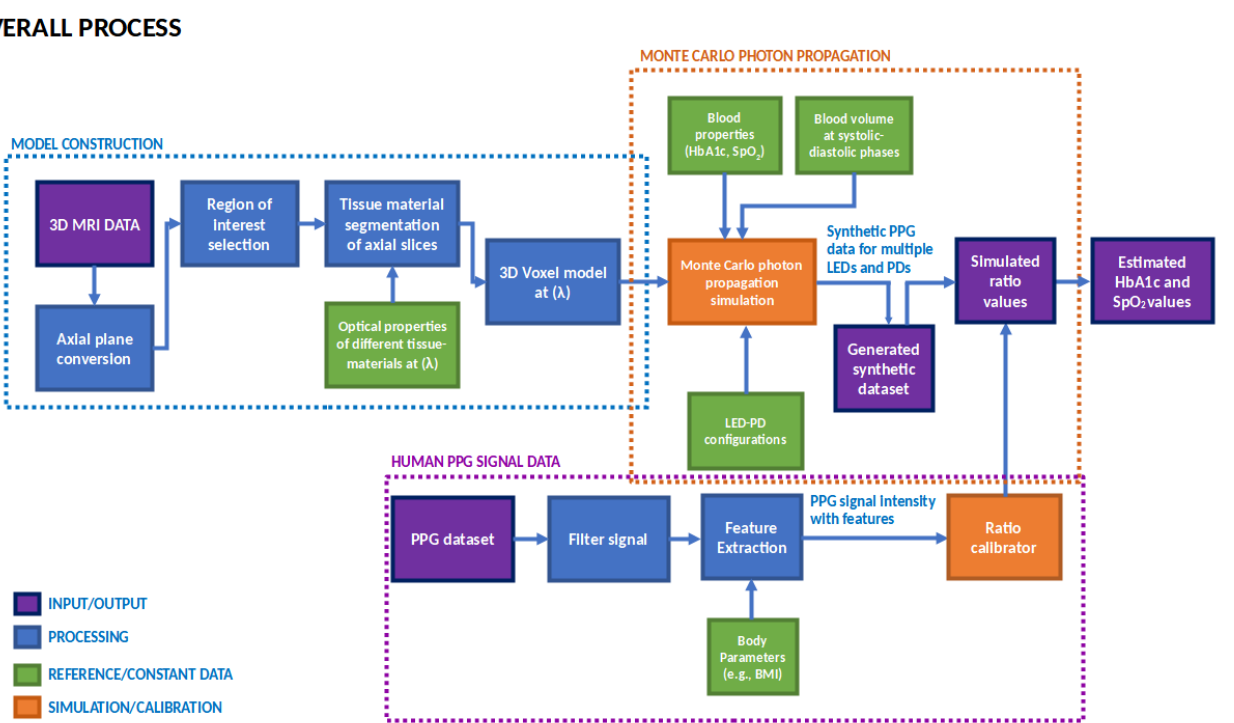
Figure 1. Overall block diagram of the HbA1c estimation method using the Monte Carlo photon propagation simulation.